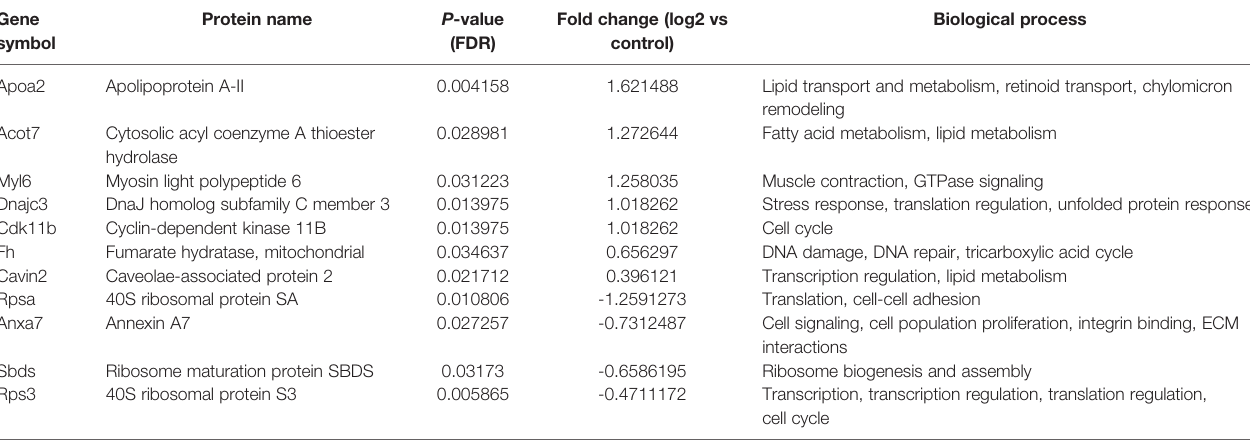
TABLE 2 | List of differentially regulated proteins in AG.1 treated group vs control group. Positive fold-change value denotes up-accumulation and negative fold change value denotes down-accumulation in comparison with control. Gene symbol